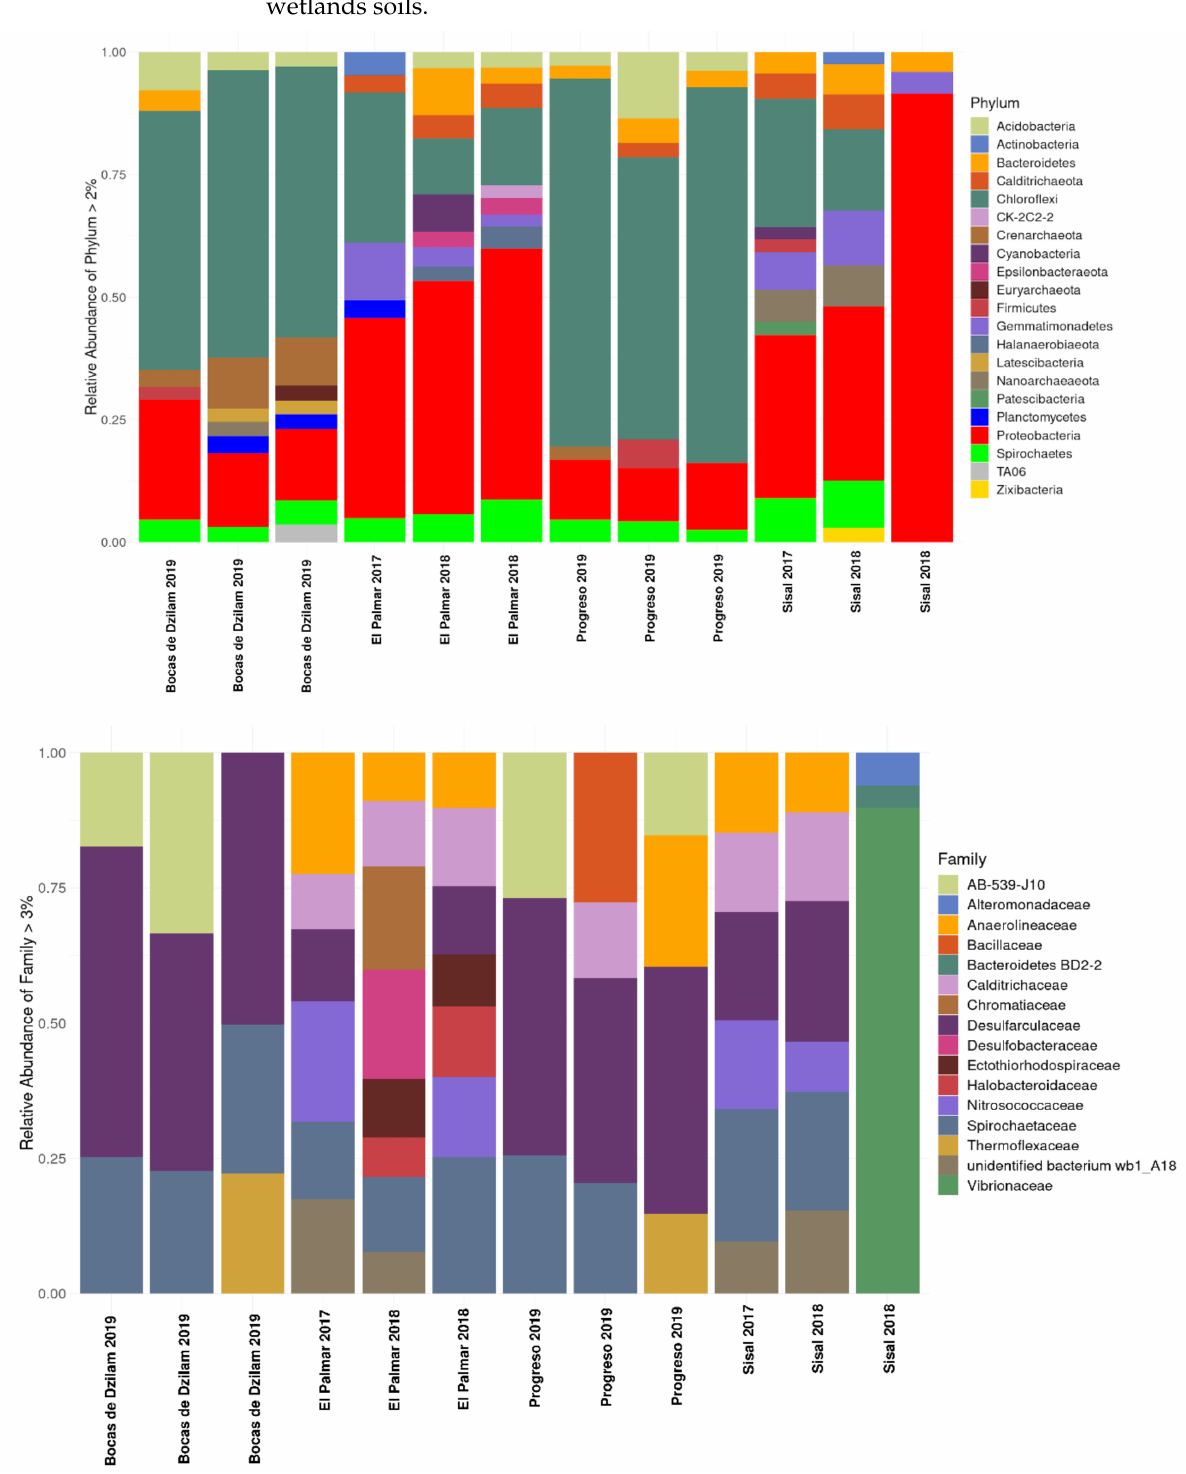
Figure 1. Relative abundance of bacteria composition across the four wetland sampling sites at phylum ( upper ) and family ( bottom ) levels. Conserved sites: Bocas de Dzilam and El Palmar; contaminated sites: Progreso and Sisal. X-axis: sampled locations (including the year). Y-axis: relative abundance of